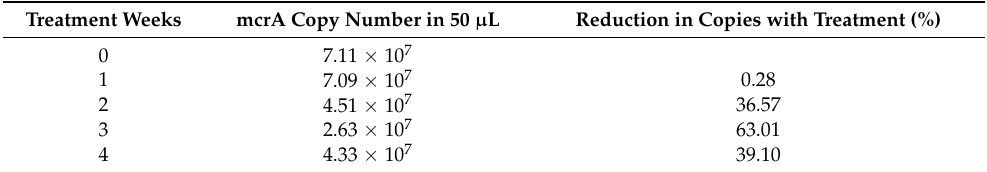
Table 5. Reduction in the mcrA gene copies and the treatments. All the comparisons are made with treatment week 0 and expressed in % of